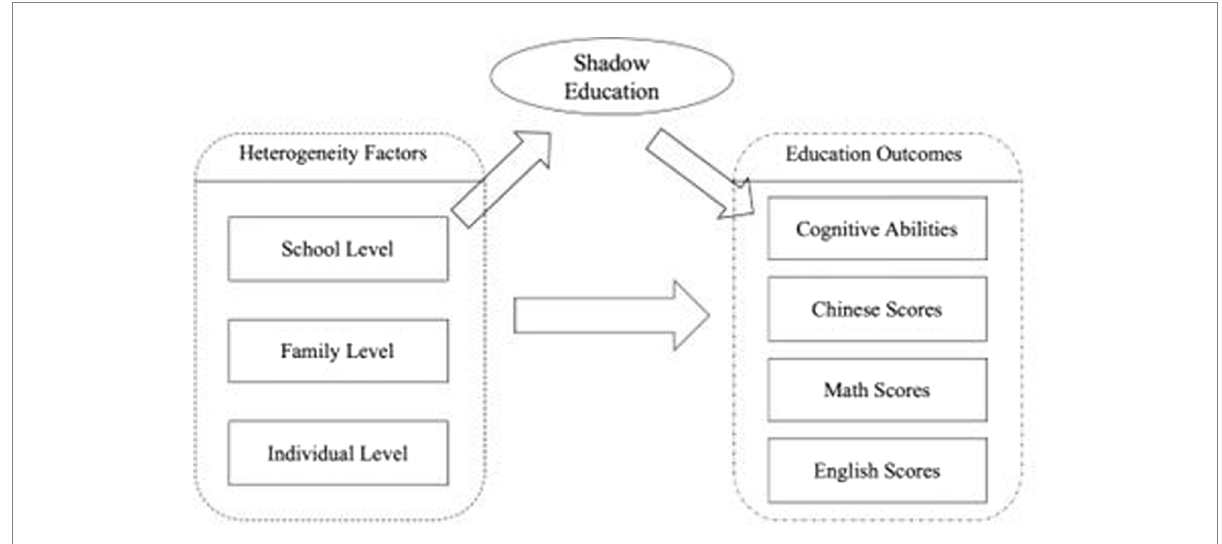
FIGURE 2 Shadow education mediation